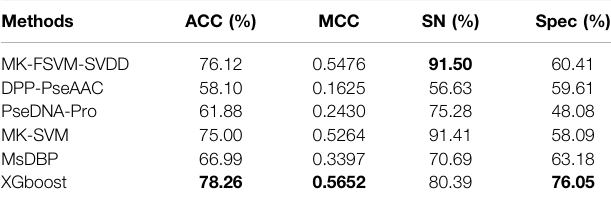
TABLE 5 | Experimental fi ndings for the independent data set PDB2272 using the XGBoost algorithm and other models. Methods ACC